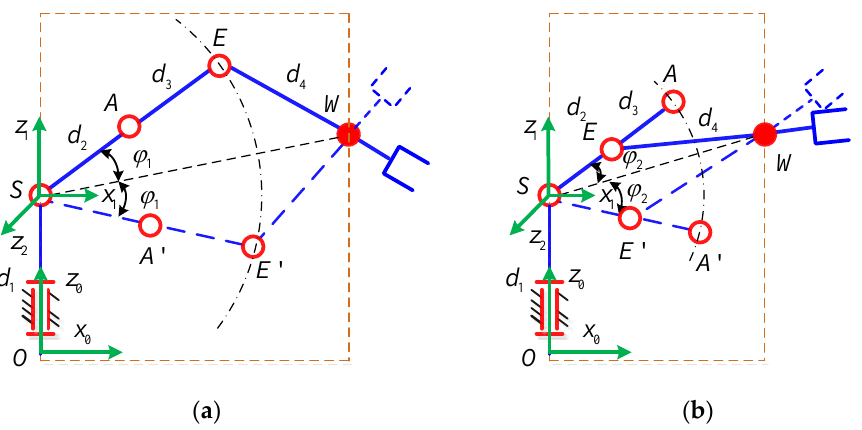
Figure 7. ( a ) Singular configuration corresponding to θ 6 = 0 or π, θ 3 = 0; ( b ) Singular configuration corresponding to θ 6 = 0 or π, θ 3 = π.